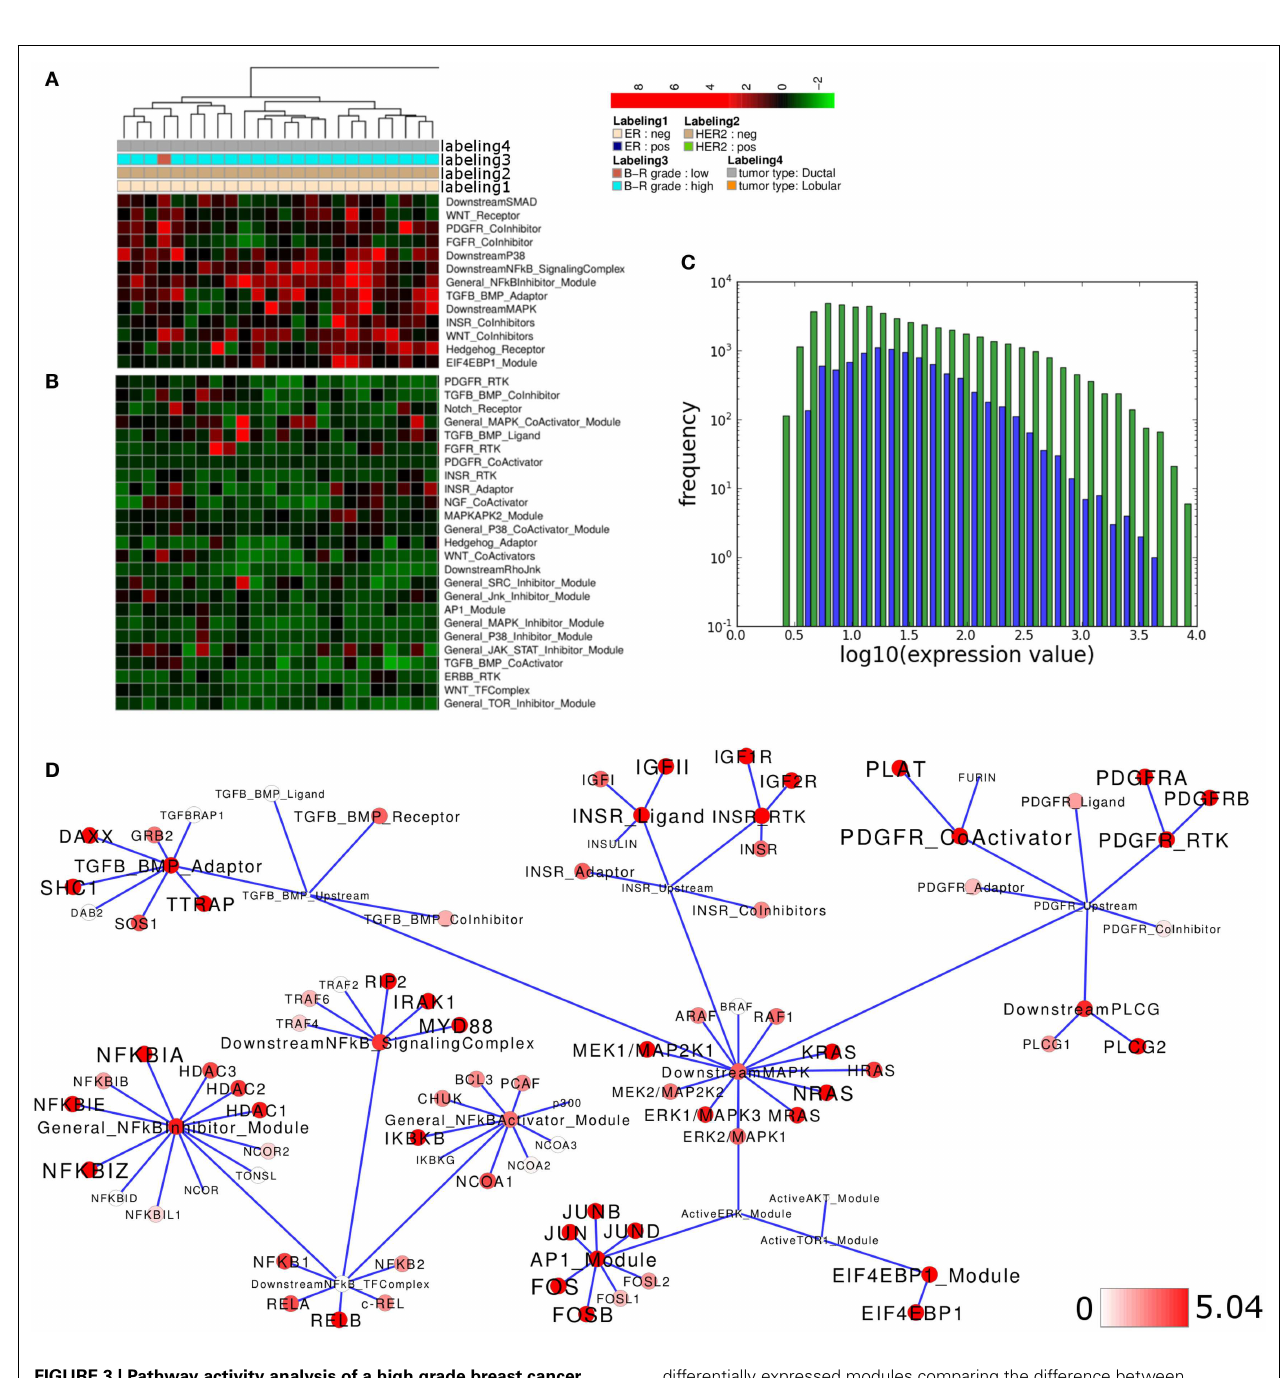
FIGURE 3 | Pathway activity analysis of a high grade breast cancer subcluster . (A,B) Regions of the heatmap in Figure 2A that appear to distinguish high grade ER-negative HER2-negative samples from all other samples in the Lu et al. (2008) data set. (C) Plot showing distribution of log10 values of all network module activity values (blue bars) for all breast cancer samples versus log10 gene-expression values (green bars) of all genes associated with the network. (D) Network diagram of the top 15%